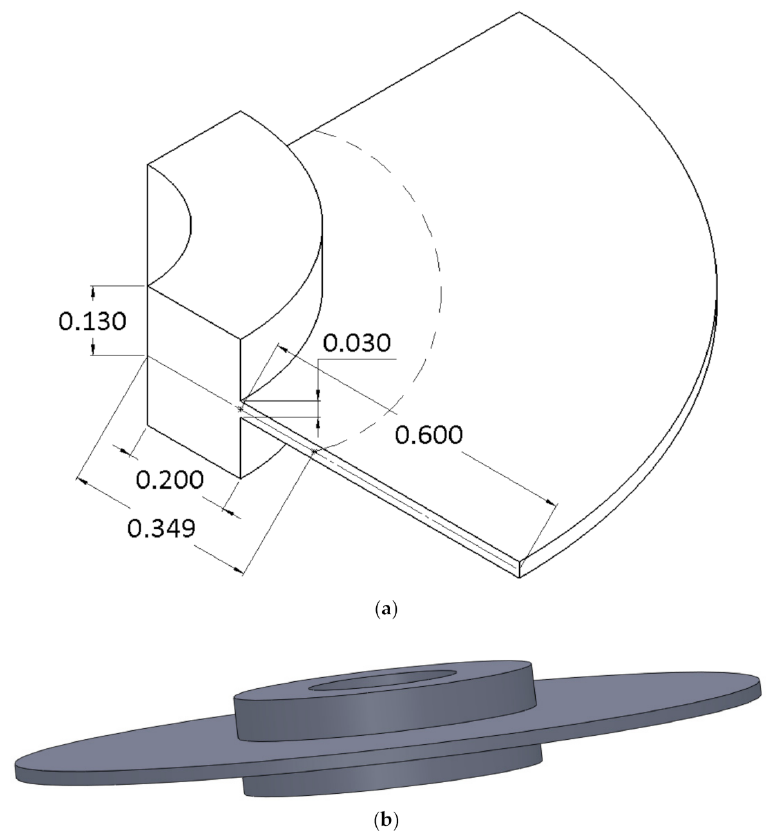
Figure 2. ( a ) The dimensions of a quarter of a single rectangular shape annular fin. ( b ) A complete rectangular shape annular fin of Figure